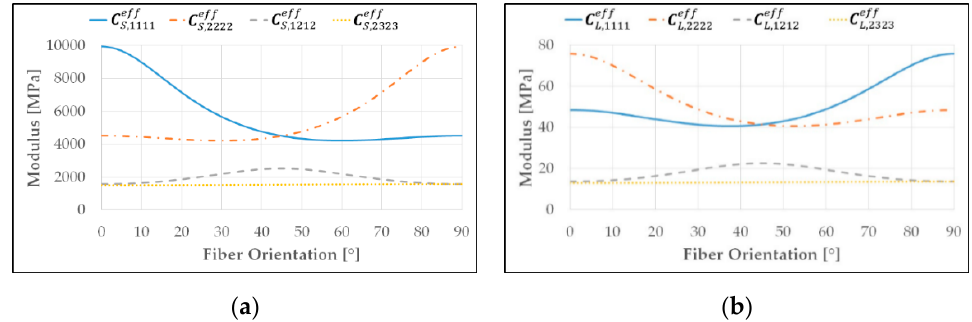
Figure 8. Components of the fourth ranked ( a ) stiffness and ( b ) damping tensors of PA66 ‐ GF30 at 23 °C and 0% rh.